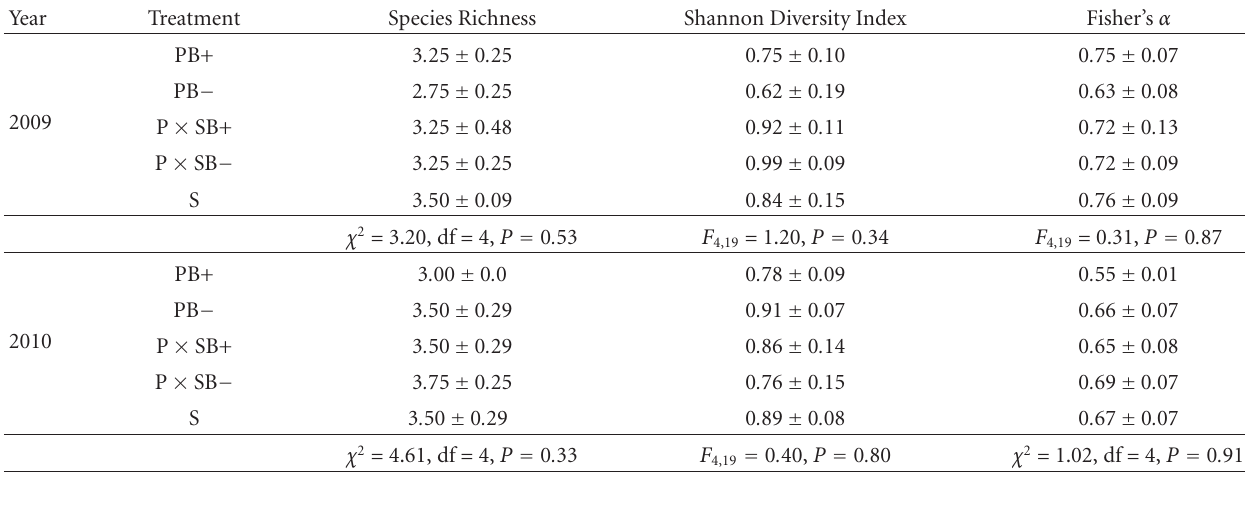
Table 1: Mean ( ± 1SE) values of species richness, Shannon Diversity Index, and Fisher’s α by treatment in 2009 and 2010. Rodents were captured and released on site at the Lenoir 1 Sustainability Study Site, in Lenoir Co., NC, during 15 July–9 December, 2009 and 19 July–14 November, 2010. Statistical results are from comparisons using a 1-way ANOVA or Kruskal-Wallis test when parametric assumptions were not met. Kruskal-Wallis test statistics are reported as χ 2 estimates. Treatments: PB+ = Pine Biomass+; PB − = Pine Biomass − ; P × SB+ =